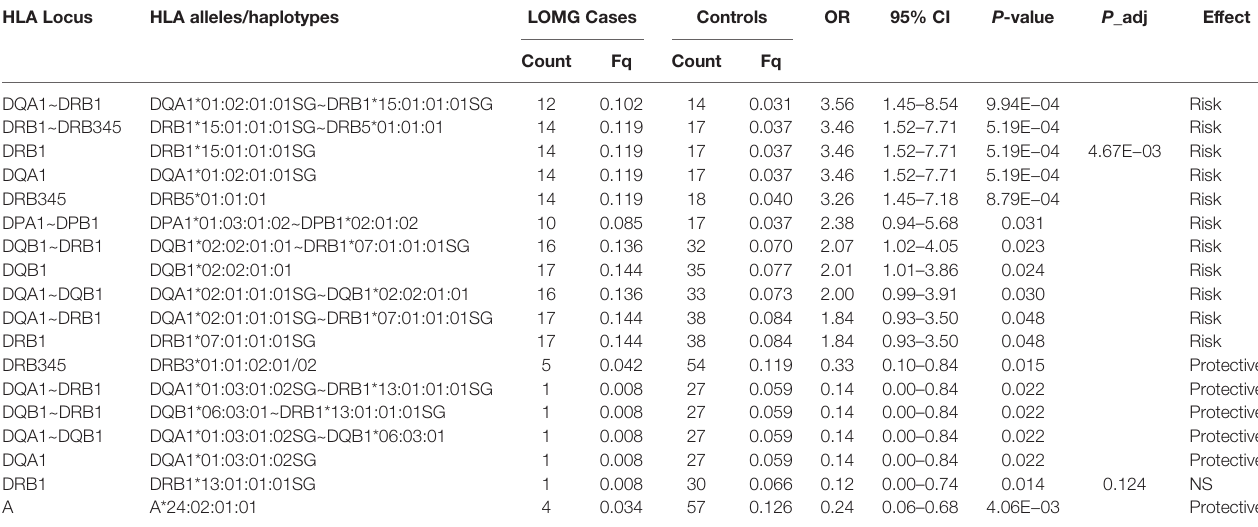
TABLE 5 | Signi fi cant associations of HLA alleles and haplotypes in Italian LOMG AChR-antibody positive cases and controls ranked by odds ratios. HLA Locus HLA